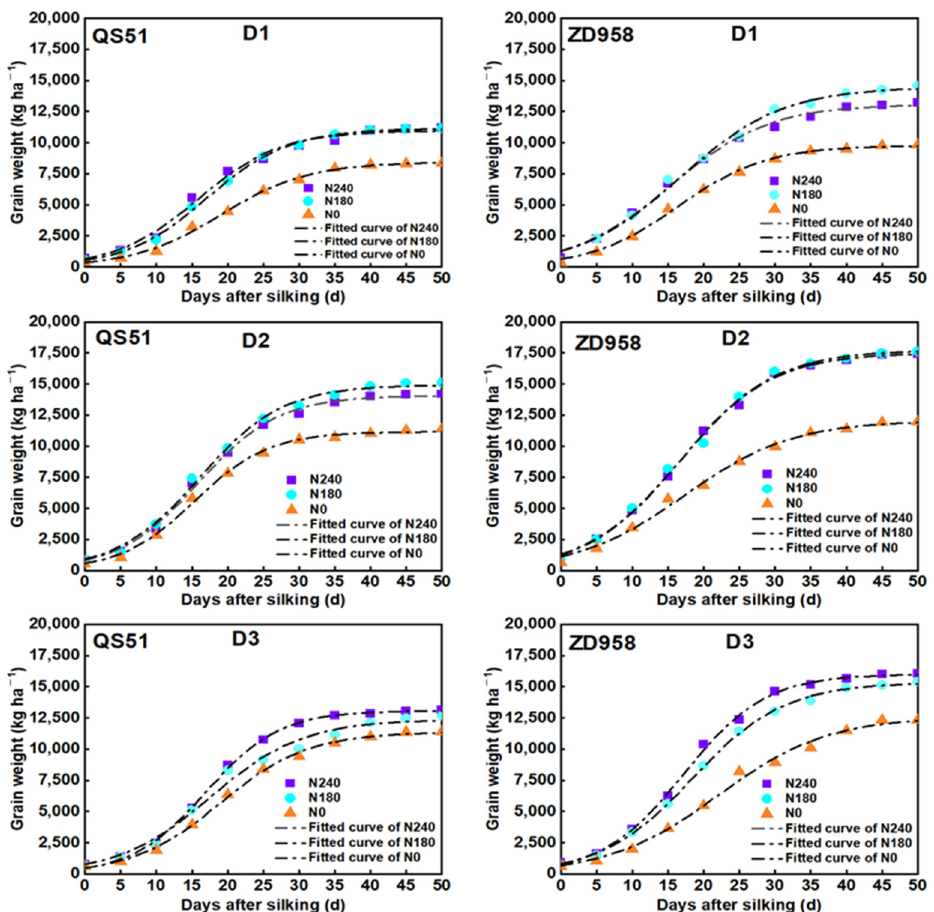
Figure 6. Dynamic changes of grain weight for QS51 and ZD958. D1: 80,000 plants ha − 1 ; D2: 100,000 plants ha − 1 ; D3: 120,000 plants ha − 1 ; N0: no N application; N180: 180 kg N ha − 1 ; N240: 240 kg N ha − 1 . Table 2. Analysis of variance of maize grain weight characteristics parameters at different planting densities and nitrogen rates for QS51 and ZD958.